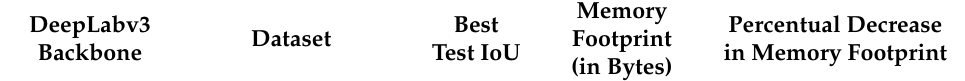
Table 3. Best Results obtained with the proposed pruning algorithm.